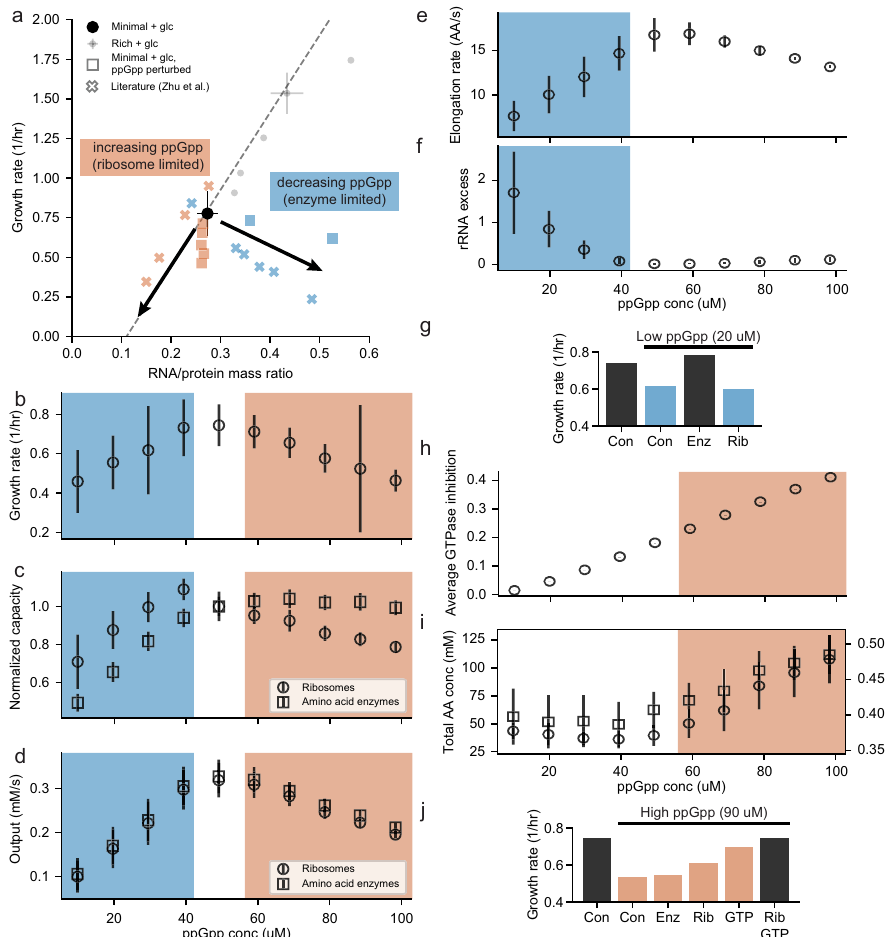
Fig. 3 ppGpp regulation of growth depends on two small molecule feedback inhibition pathways in addition to regulation of gene expression. a Growth rate vs RNA/protein mass ratio for simulations with perturbed ppGpp concentrations (squares and circles) and literature (crosses and dashed line). Colored points represent minimal glucose media conditions with blue indicating low ppGpp with metabolic enzyme limitations and orange indicating high ppGpp with ribosome limitations. Black arrows indicate the expected trends when ppGpp is perturbed. Average growth rate ( b ), average capacity of ribosomes (circles) or amino acid enzymes (squares) normalized to wildtype capacity ( c ), average total output rates from ribosomes (circles) and amino acid enzymes (squares) ( d ), average elongation rate per ribosome ( e ), and average fraction of ribosome mass that is excess rRNA mass and not included in ribosomes ( f ) from simulations at various concentrations of ppGpp. Blue boxes indicate ppGpp concentrations leading to enzyme limitations while orange boxes represent ppGpp concentrations leading ot ribosome limitations. g Average growth rate from simulations at wildtype ppGpp concentrations, low ppGpp concentrations, and low ppGpp concentration with expression modi fi cations (con: control, enz: increased enzyme expression, rib: increased ribosome expression). Average GTPase inhibition by ppGpp ( h ) and total amino acid concentrations (left, circles) leading to an average amino acid pathway allosteric inhibition (right, squares) ( i ) from simulations at various concentrations of ppGpp. j Average growth rate from simulations at wildtype ppGpp concentrations, high ppGpp concentrations, and high ppGpp concentration with expression and/or GTPase modi fi cations (con: control, enz: increased enzyme expression, rib: increased ribosome expression, GTP: remove inhibition of GTPases). Simulation data comes from 6 generations and 8 initial seeds (4 initial seeds for g and j ) and error bars represent standard